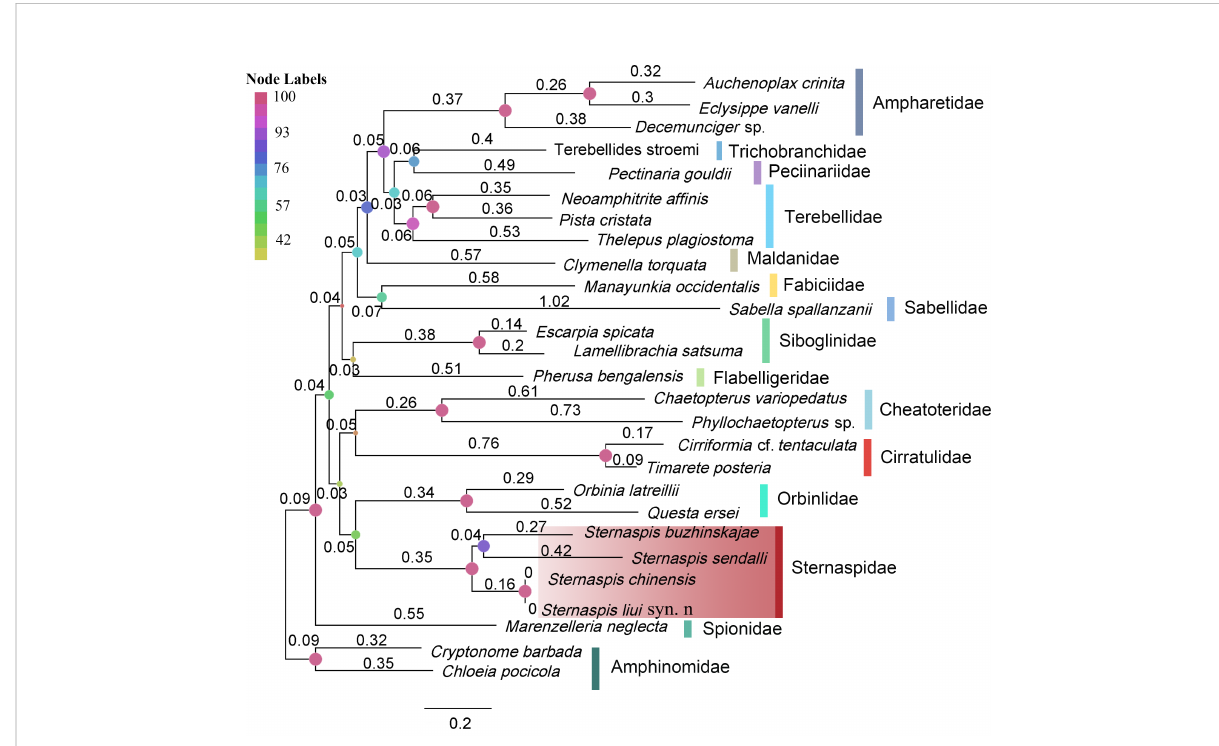
FIGURE 2 Maximum-likelihood tree based on nucleotide sequences of 13 PCGs and two rRNAs. The node labels indicated bootstrap supports. Branch lengths are indicated above the